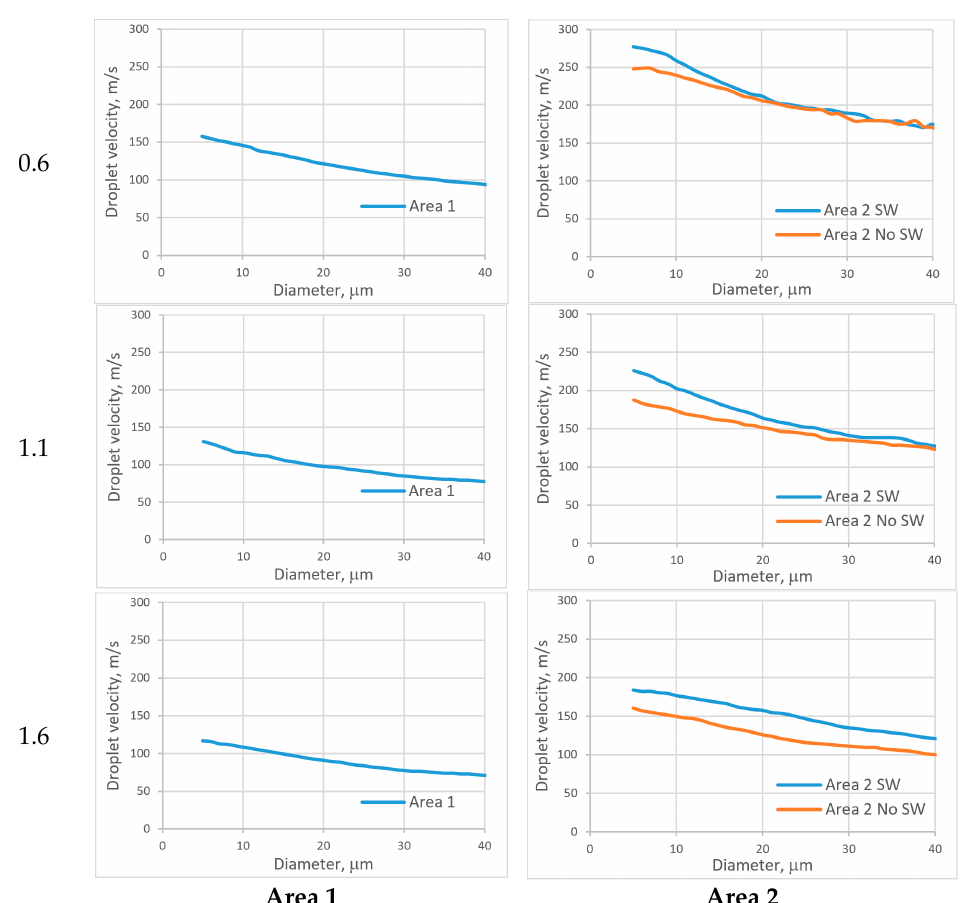
Figure A5. Velocity distribution by droplet diameters, gas flow Mach number M = 2.5. The left column shown water injection pressure p l , MPa